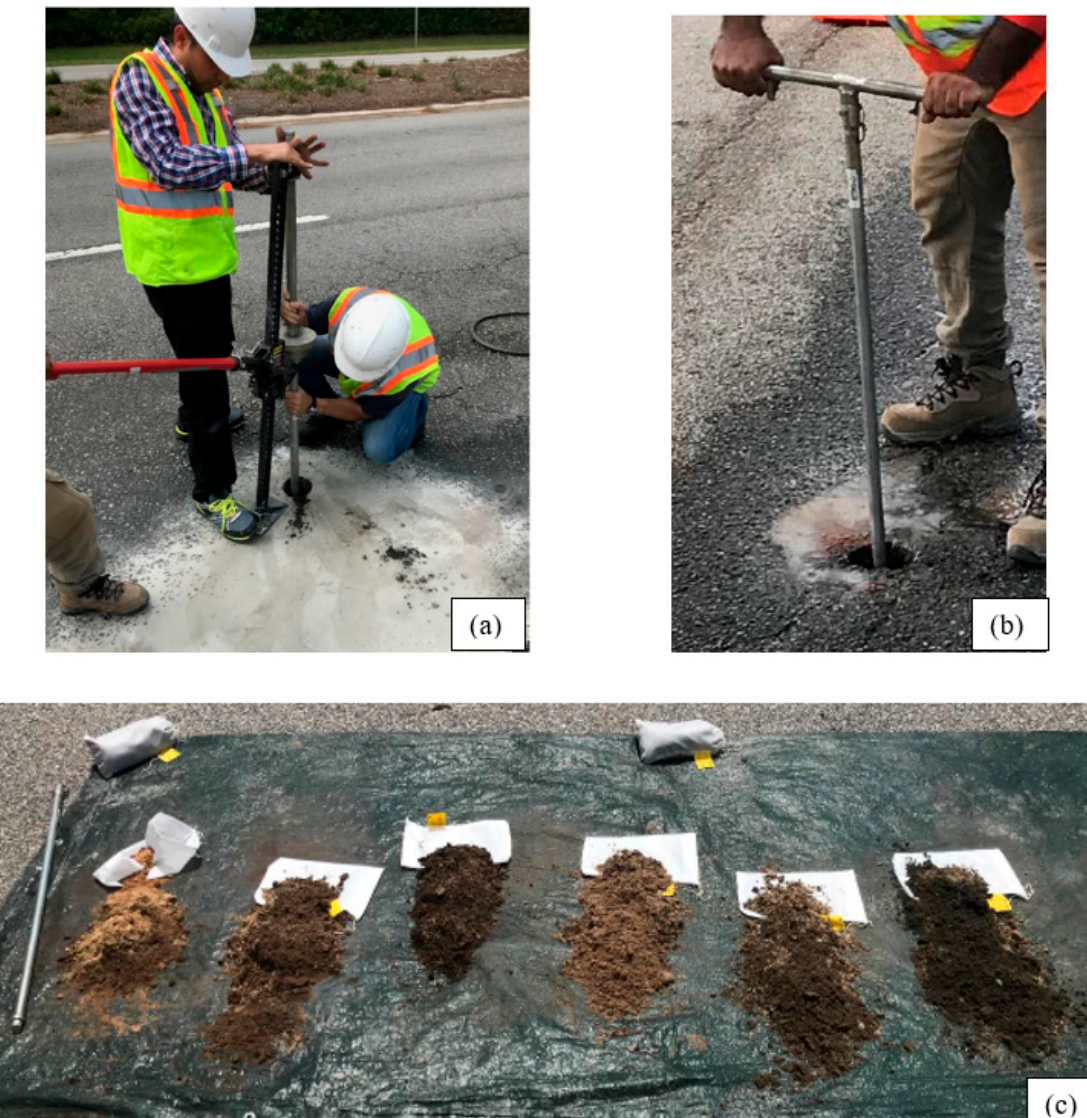
Figure 2. Subgrade sample collection process: ( a ) Shelby tube sample collected with assistance from A Jeep Jack, ( b ) Bulk sample collected by hand auger, and ( c ) Bulk samples .